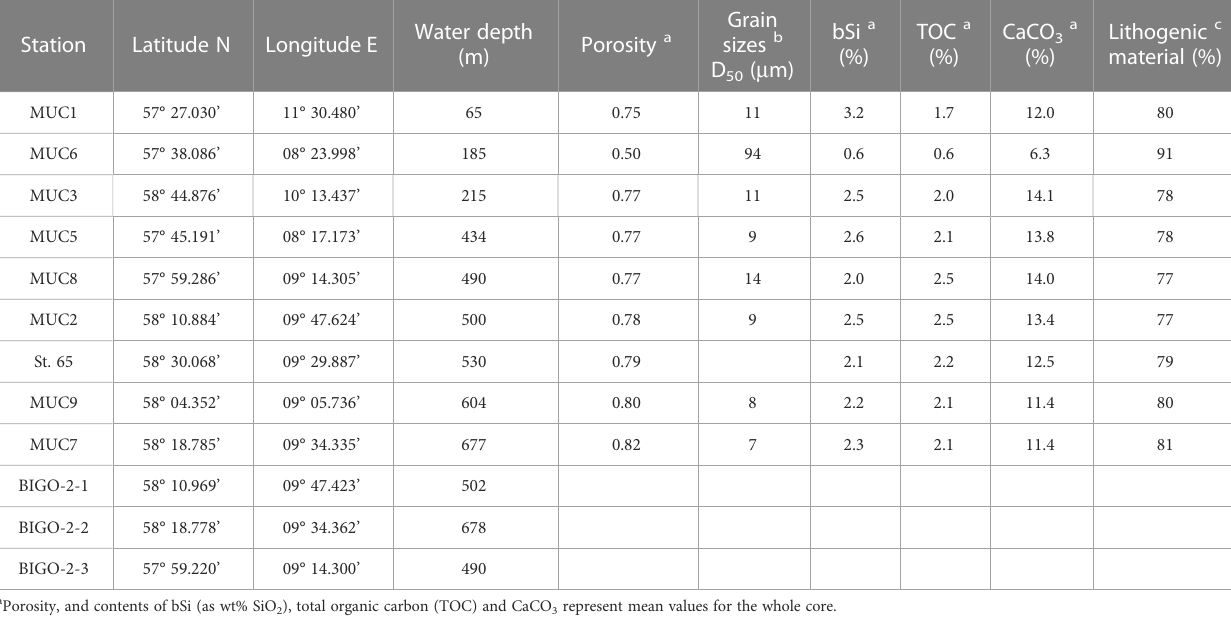
TABLE 1 Summary of sampling sites and general information on multicorer (MUC) and biogeochemical observatory (BIGO) stations.